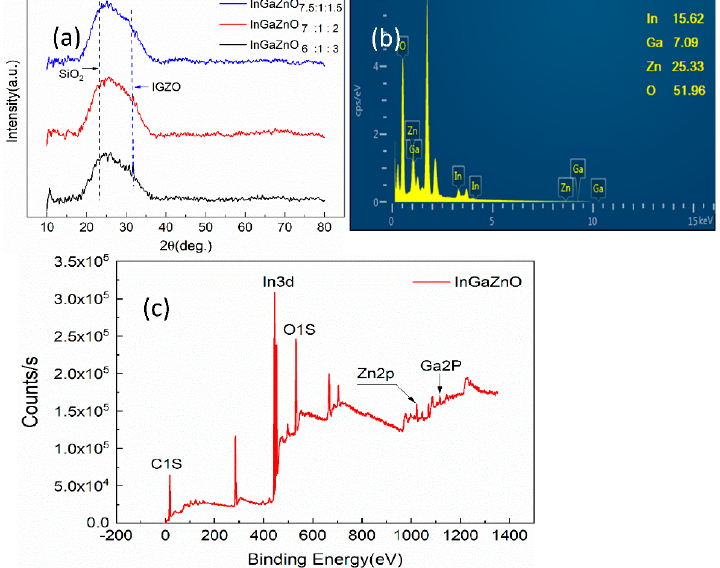
Figure 8. ( a ) X-ray diffraction (XRD) patterns of IGZO films, ( b ) energy-dispersive X-ray (EDX) image of IGZO film, ( c ) X-ray photoelectron spectroscopy (XPS) patterns of InGaZnO film.